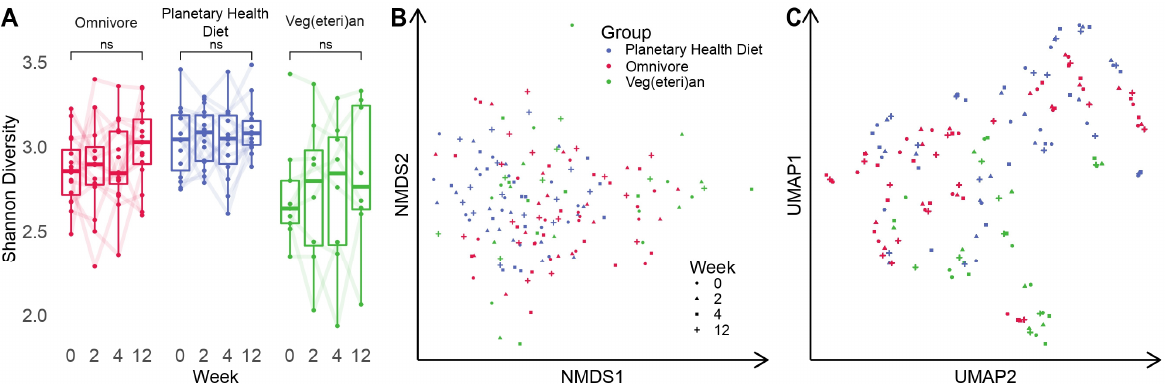
Figure 2. ( A ) α -diversity computed with the Shannon index for all time points and cohorts. Differ- ences between initial and final time points were not significant for any cohort. ns = not significant ( B ) Visualised β -diversity computed with NMDS on weighted UniFrac distances among all sample pairs. ( C ) UMAP computed on sourmash distances computed among all samples.